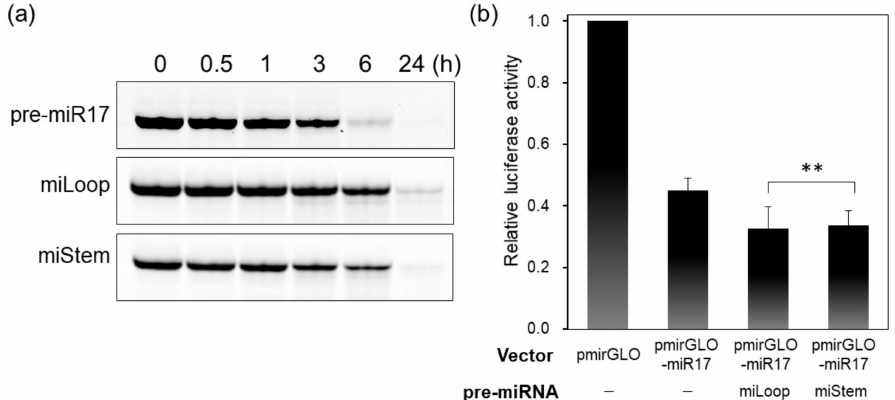
Figure 4. Biological properties of the FRET dye-conjugated pre-miR17s. ( a ) Dicing and ( b ) luciferase assay of pre-miR17s were conducted. pre-miR17 (6 µ M) was incubated with the Dicer (0.1 U/ µ L) at 37 ◦ C. The reaction mixtures were analyzed by 20% native PAGE. The luciferase reporter assay was performed by the transfection of the pmirGLO or pmirGLO-17 plasmid. The plasmid and pre-miR17 (30 nM) were transfected into the HeLa cells. The luciferase activity of the cells that were transfected with pmirGLO was set to 1.0. Plotted are means and SD (n = 3) of firefly/ Renilla luciferase signal relative to the untreated sample. ** not significant ( p > 0.1, miLoop vs.